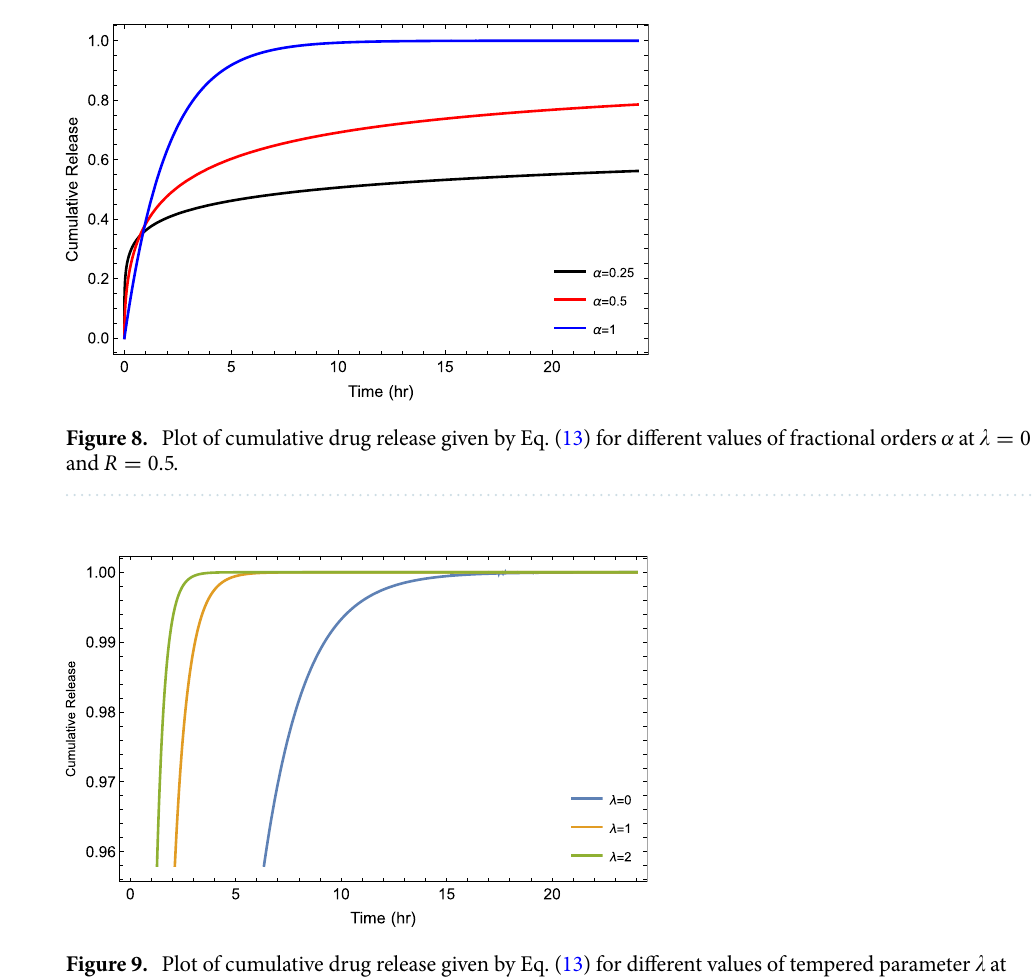
Figure 9. Plot of cumulative drug release given by Eq. (13) for different values of tempered parameter (cid:31) at α = 1 and R = 0.5